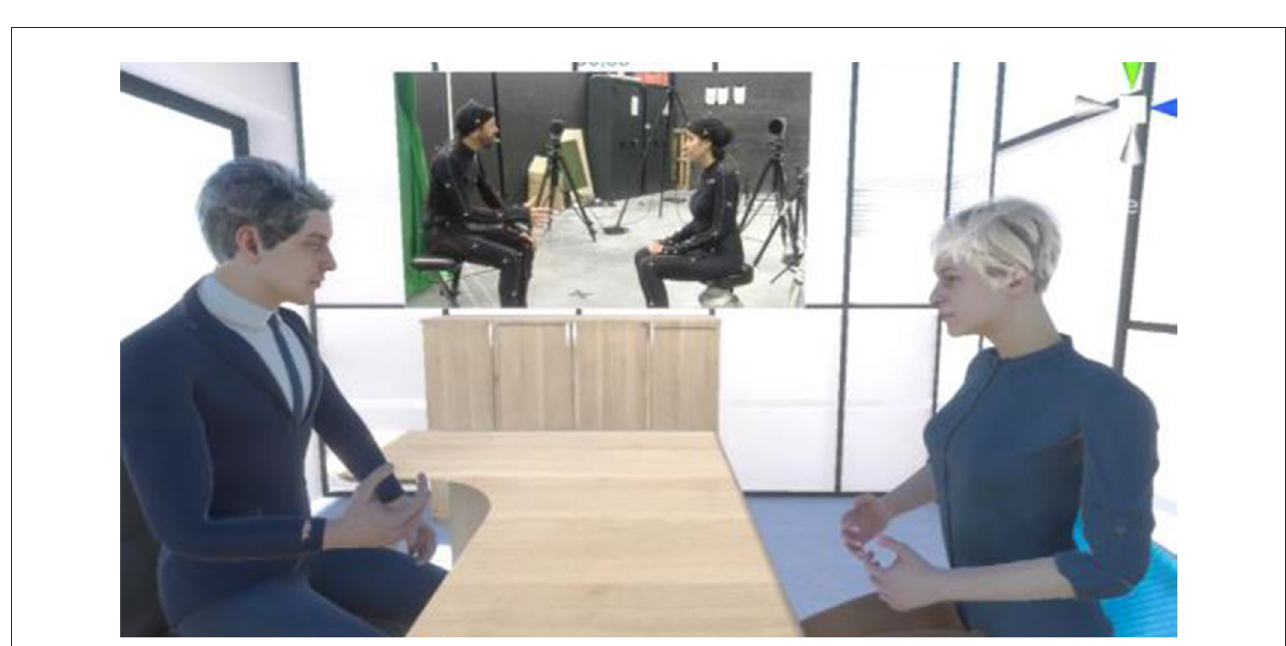
FIGURE9 Screenshot of a discrimination scene replayed by virtual actors.